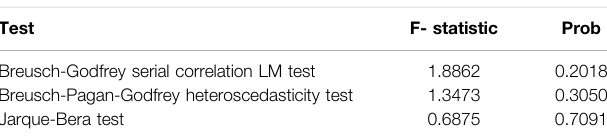
TABLE 7 | Diagnostic tests results.